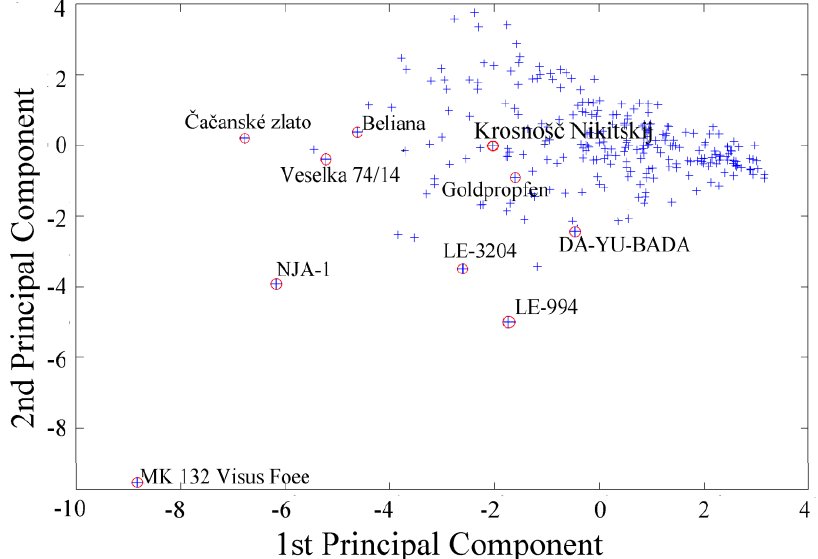
Figure 2. Statistical expression of extreme values of amino acids content represented by two principal components. The marked apricot cultivars had the extreme values markedly different from the